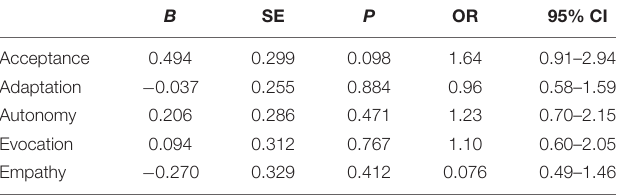
TABLE 5 | Motivational interviewing (case strength).